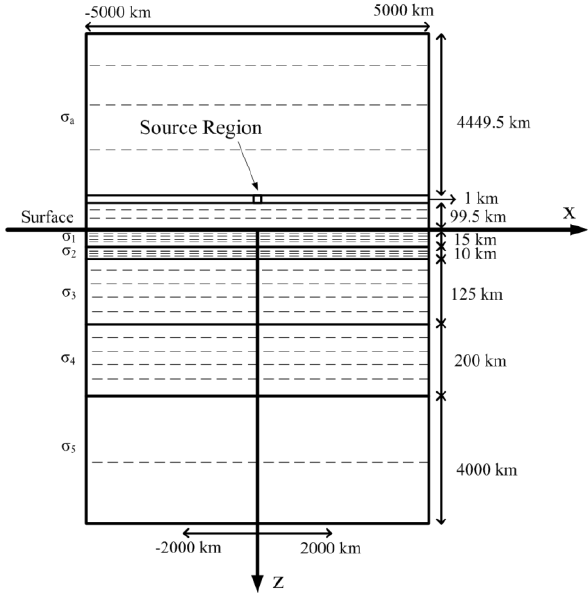
Fig. 1. Sketch of the physical and computational model used for evaluation of electric and magnetic fields. The dashed horizontal lines represent computational boundaries whereas the solid lines are physical boundaries. A large physical model is necessary to sat- isfy the boundary conditions of the magnetic field being sufficiently attenuated. The conductivities and thicknesses of the different lay- ers can be varied depending on the layered Earth model. A cur- rent is placed at 100km above the surface in a thin 1km layer. The computational gridding of 1km in the x dimension is omitted for clarity. For the Quebec layered earth model, σ 1 = 0 . 00005Sm − 1 , σ 2 = 0 . 005Sm − 1 , σ 3 = 00 . 001Sm − 1 , σ 4 = 0 . 01Sm − 1 and σ 5 = 0 . 333Sm − 1 , and the layer thicknesses are shown in the figure. a simple line current in free space is compared with the field from FEM. The FEM results are represented by solid lines and exact values are represented by symbols. The line cur- rent is placed 100 km above the horizontal distance of 0